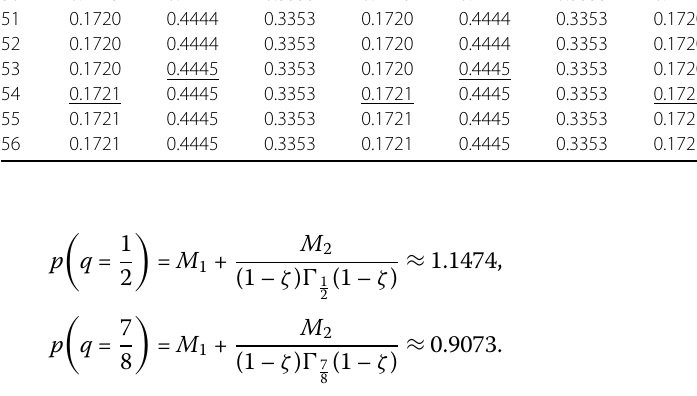
, 1 , 7 and (1) (cid:13) I σ –1 q [ g 1 ] (cid:13) 5 2 8